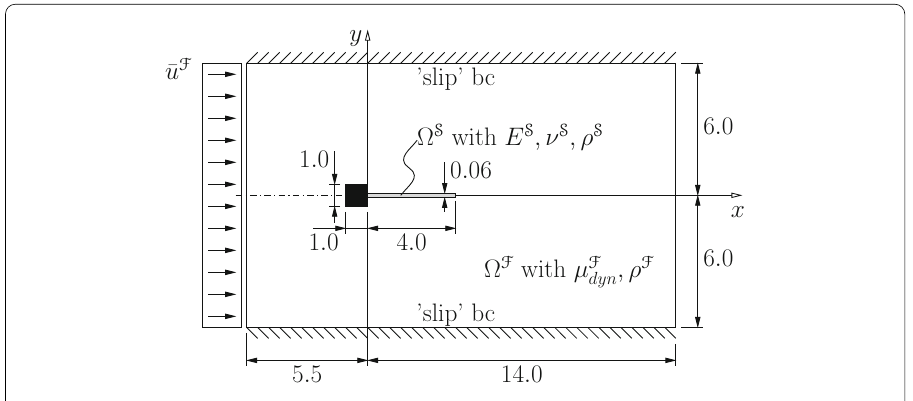
Fig. 9 Problem sketch of a flexible flag attached to a rigid obstacle and subject to fluid flow—the solid flag is clamped at x = 0. The fluid inflow velocity ˆ¯ u F ( t ) is prescribed in x -direction. The fluid flow along the top and bottom channel wall is